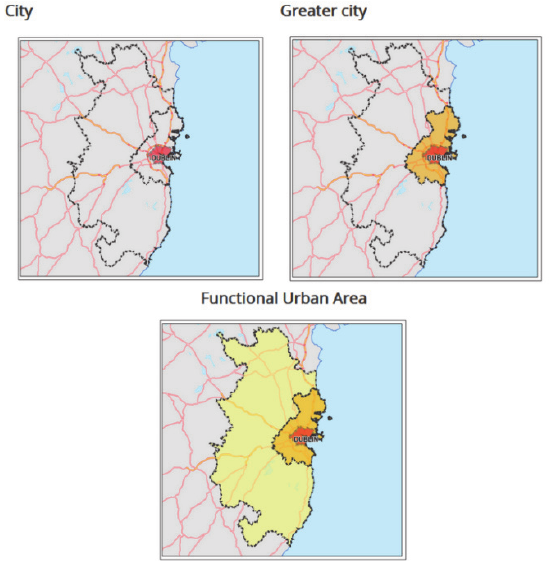
Fig. 1. Spatial levels of Dublin (European Commission,